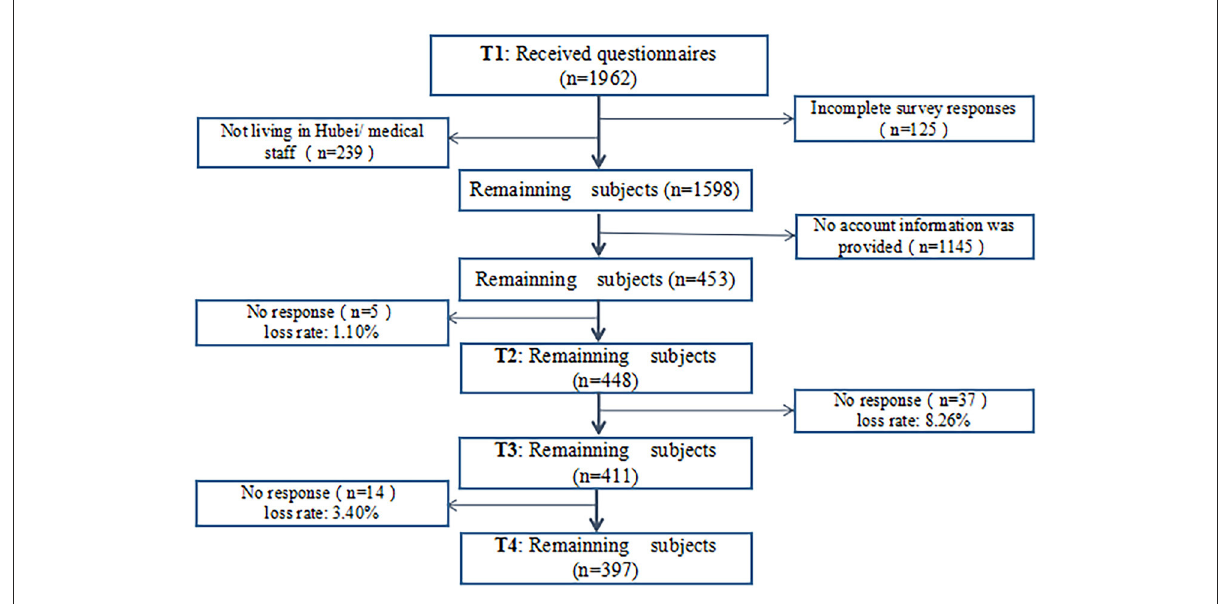
FIGURE2 The concrete flow of subject